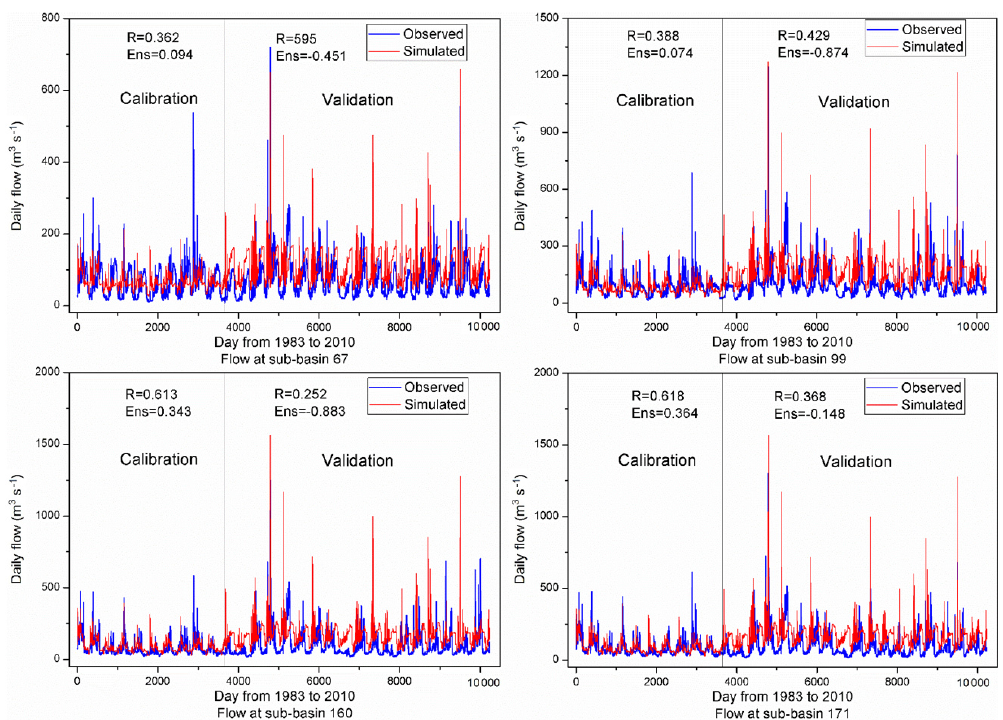
Figure 7. Calibration and validation results under the R2S2 scenario (RiverWare for reservoir operation and groundwater as the water source for irrigation).